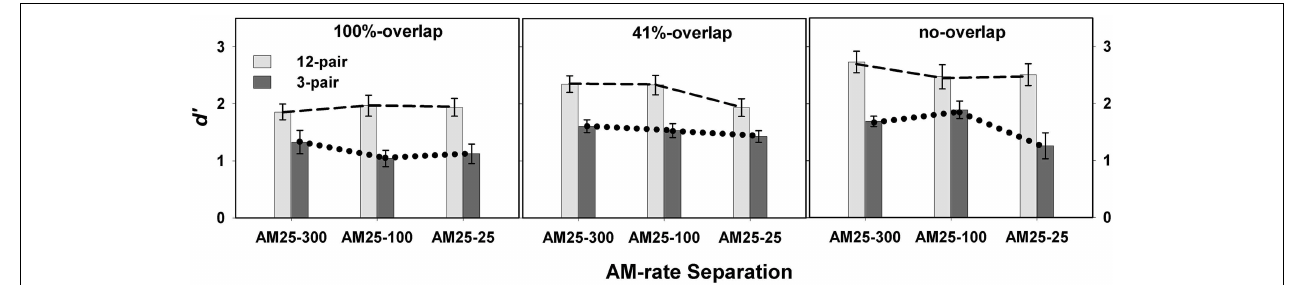
FIGURE 4 | Mean d ′ -values for 12-pair and 3-pair conditions in Experiment 1 are illustrated as a function of AM-rate separation in three spectral separation conditions: no-overlap, 41%-overlap, and 100%-overlap. Error bars represent ± one standard errors.